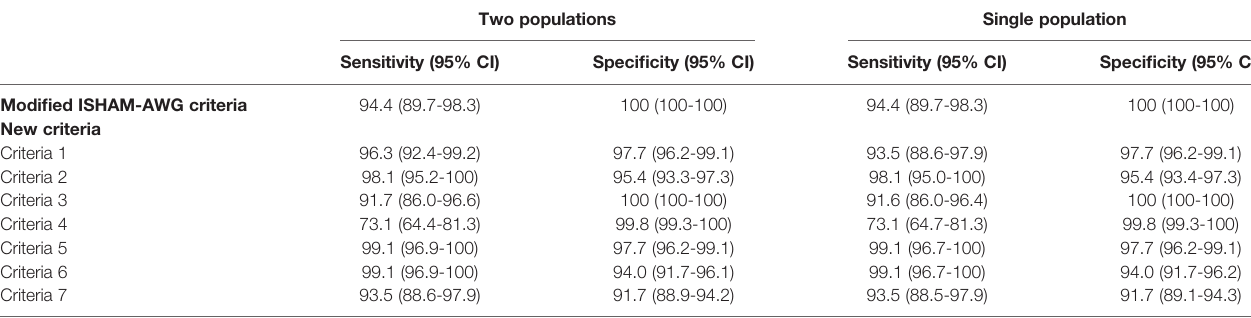
TABLE 3 | Diagnostic performance of various criteria for diagnosing allergic bronchopulmonary aspergillosis (ABPA) using latent class analysis.